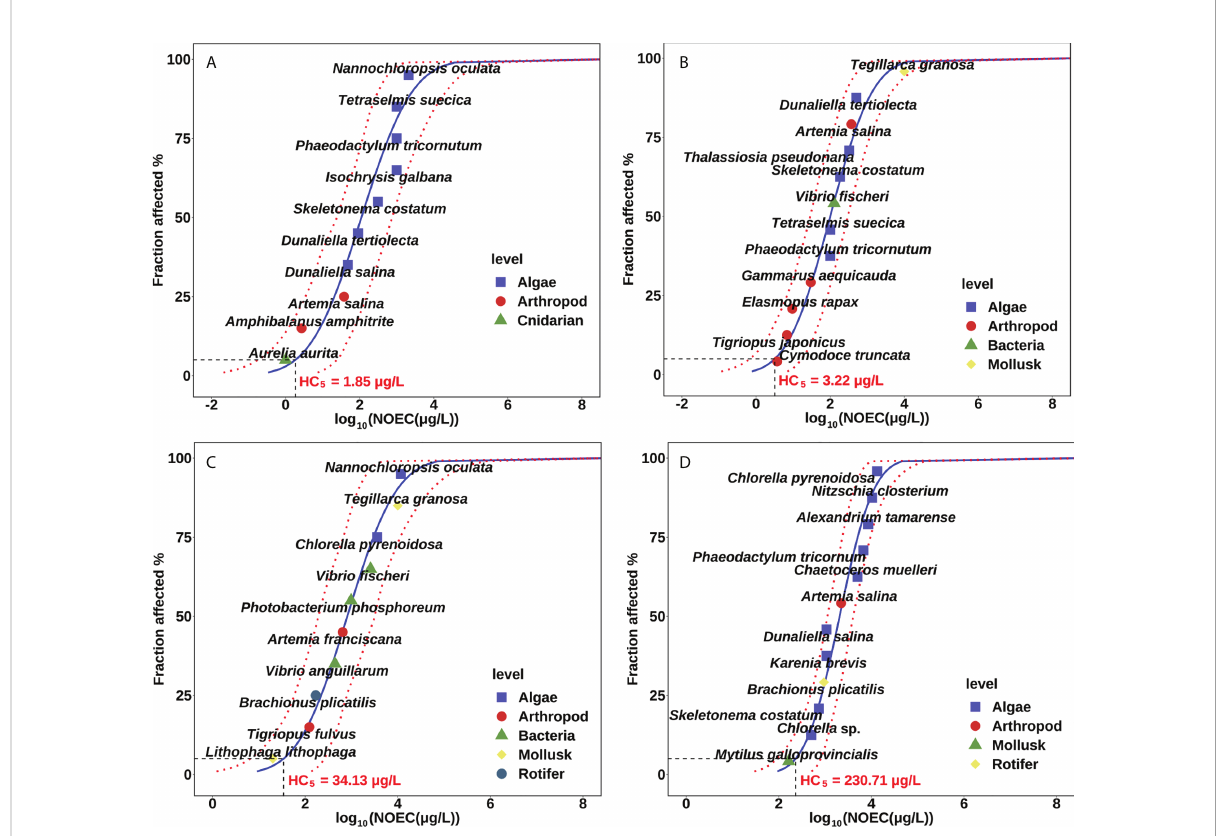
FIGURE 1 Marine species sensitivity distribution of (A) Ag, (B) ZnO, (C) CuO, and (D) TiO 2